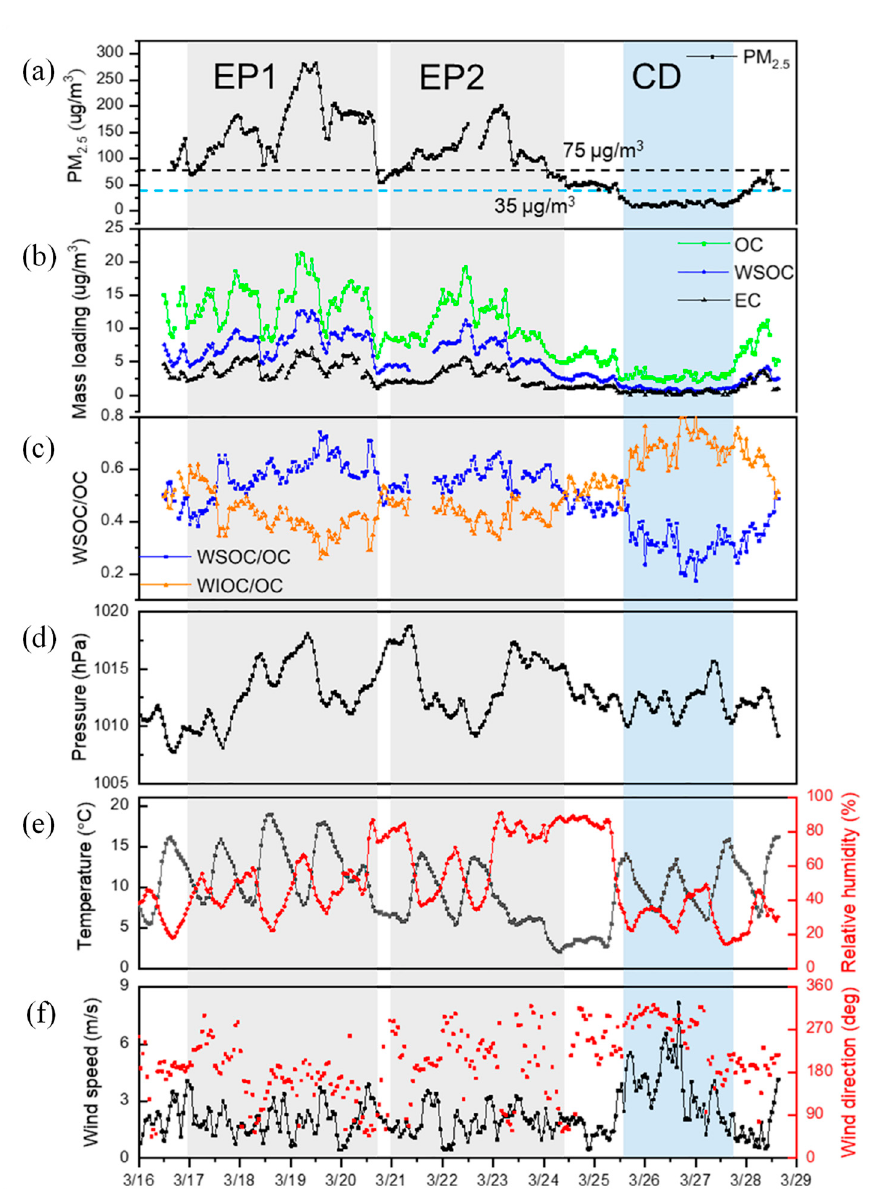
Figure 2. Time series of concentrations of ( a ) PM 2.5 , ( b ) OC, EC, and WSOC, ( c) ratios of WSOC / OC and WIOC / OC, and ( d – f ) meteorological parameters during the study period, including two pollution episodes (EP1 and EP2) and one clean day (CD) period. Note: The dashed black and light blue lines indicate PM 2.5 levels of 75 µ g / m 3 and 35 µ g / m 3 , respectively. The gray and light blue shaded areas refer to the EP and CD periods, respectively. OC: Organic carbon, WSOC: water-soluble organic carbon, EC: elemental